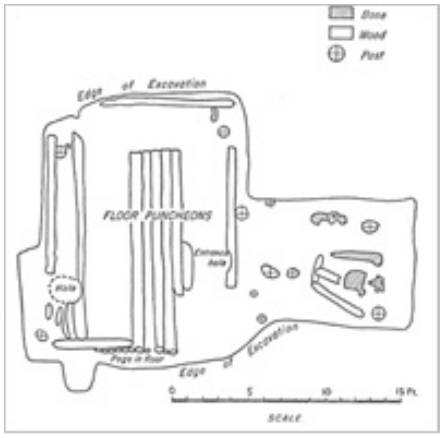
Figure 8: Utqiagvik, House A (from Ford 1959: